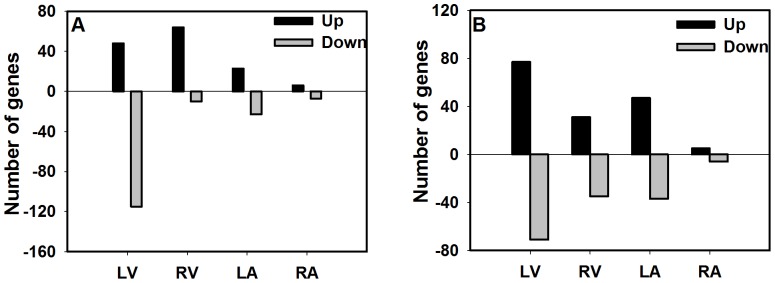
Total number of significantly altered genes observed using microarray global transcriptome expression analysis.Whole transcriptome analysis was performed on the left ventricle (LV), right ventricle (RV), left atrium (LA) and the right atrium (RA) of rhesus monkey (Macaca mulatta) fetuses that were exposed maternally to a 400 µg/kg body weight, Bisphenol A (BPA), relative to matched control fetuses, either during, (A) early gestation, EG (days; 50–100±2) or, (B) late gestation, LG (days 100±2–term). Genes that changed by greater than ±1 log2 fold change (1 LFC = 2 fold change) at an unadjusted p≤0.01 were considered significant and differentially expressed. Bars represent the number of upregulated (positive y-axis) or downregulated (negative y-axis) genes in each of the tissues.